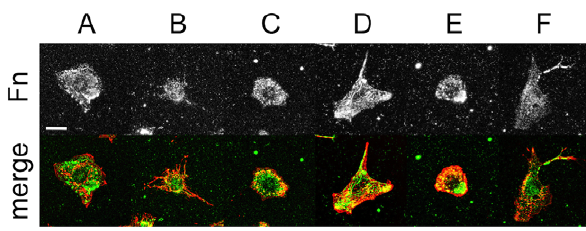
Figure 8. Fixed and stained images of fibronectin and the membrane of C2C12 cells. Cells were exposed to inhibitors for 60 min and then fixed and stained for the presence of fibronectin (Fn, greyscale and green in the merge) and the plasma membrane (red in the merge). LSCM images were acquired at the cell-substrate interface. ( A ) Control (scale bar=20 m m and applies to all), ( B ) Cyt-D, ( C ) nocodazole, ( D ) Y-27632A, ( E ) ML-7 and ( F ) blebbistatin treated cells. In all cases, cell-secreted fibronectin was distributed over the substrate and found in higher concentrations underneath the cell body.